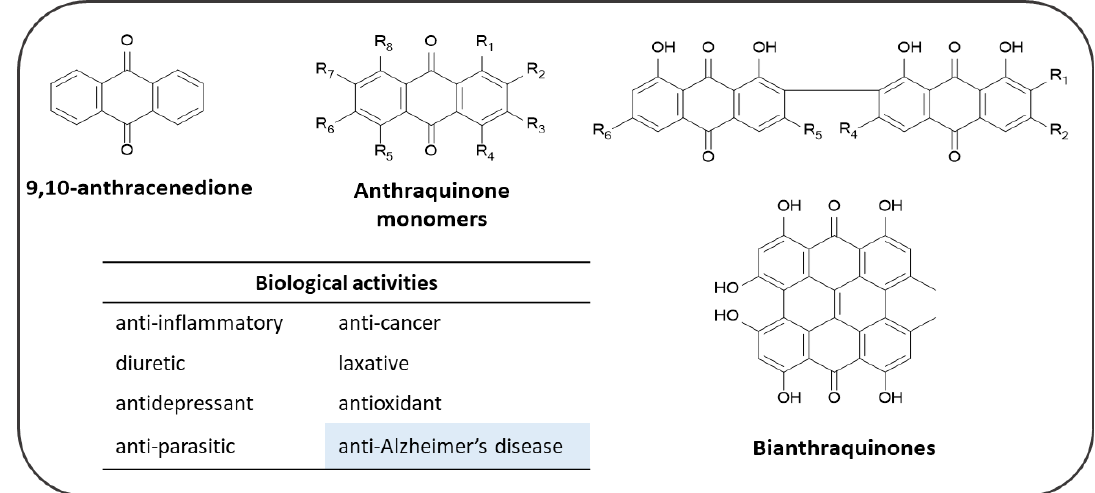
Figure 11. Overview of the biological properties of 9,10-anthracenedione parent scaffold and of the related derivatives from natural sources.